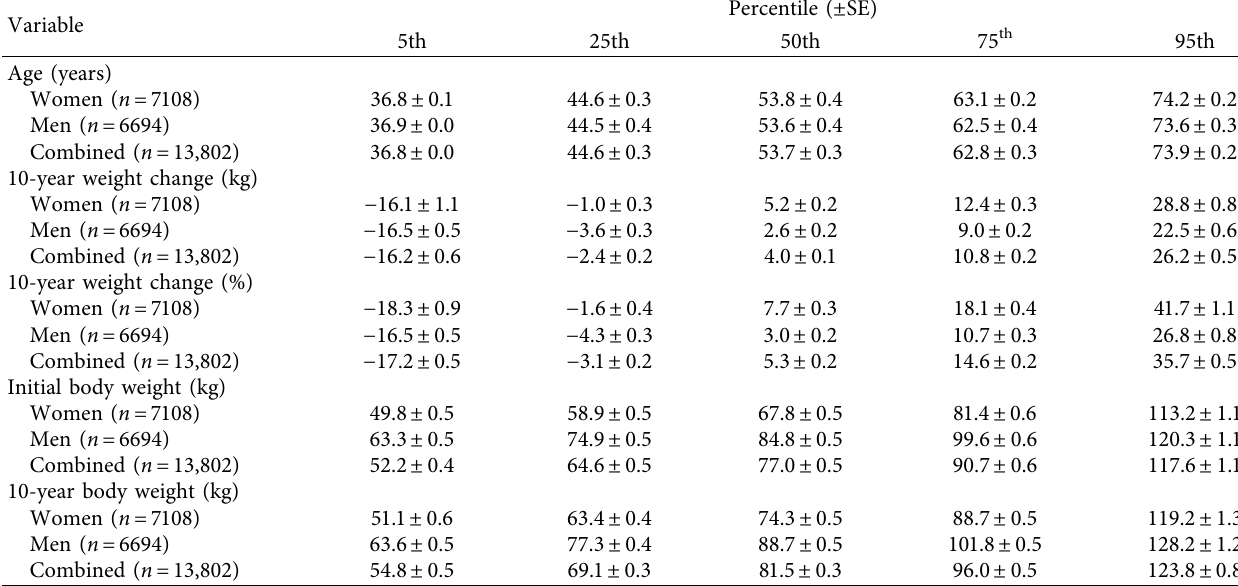
Table 2: Percentile distributions of the key variables representing US women and